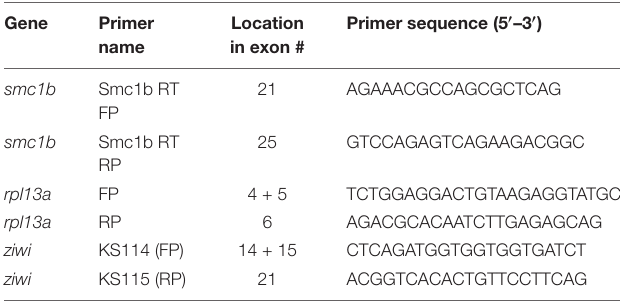
TABLE 1 | RT-PCR primers.